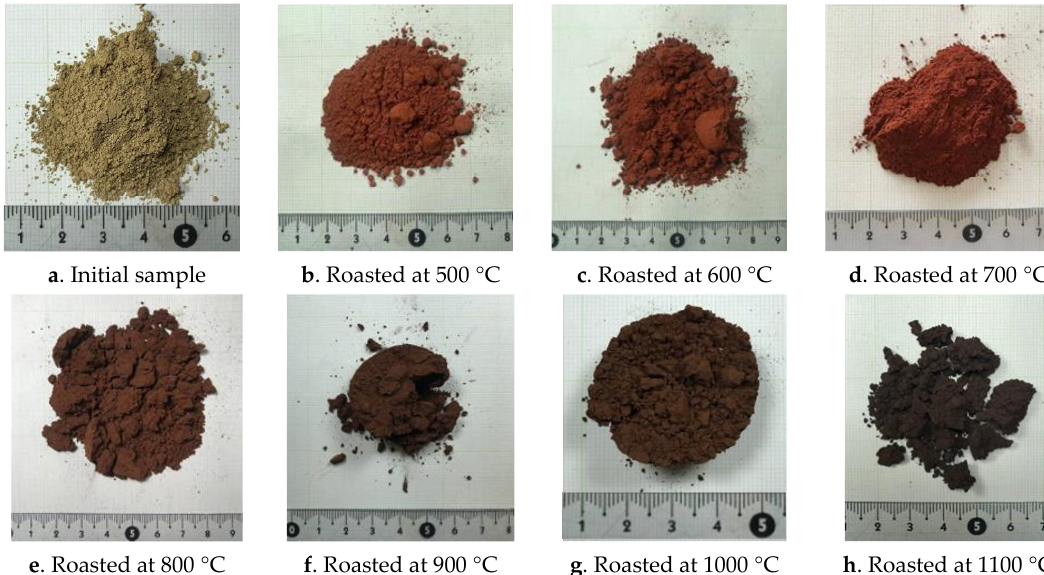
Figure 1. The physical appearance of the samples before and after roasting at different temperatures for 4 h.